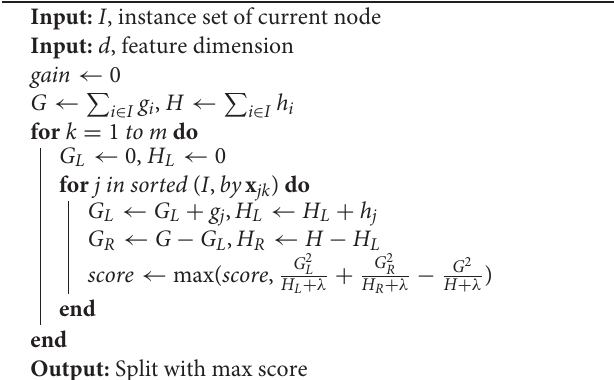
TABLE 1 | Validation analysis of algorithm sentiment prediction by manual inspection.